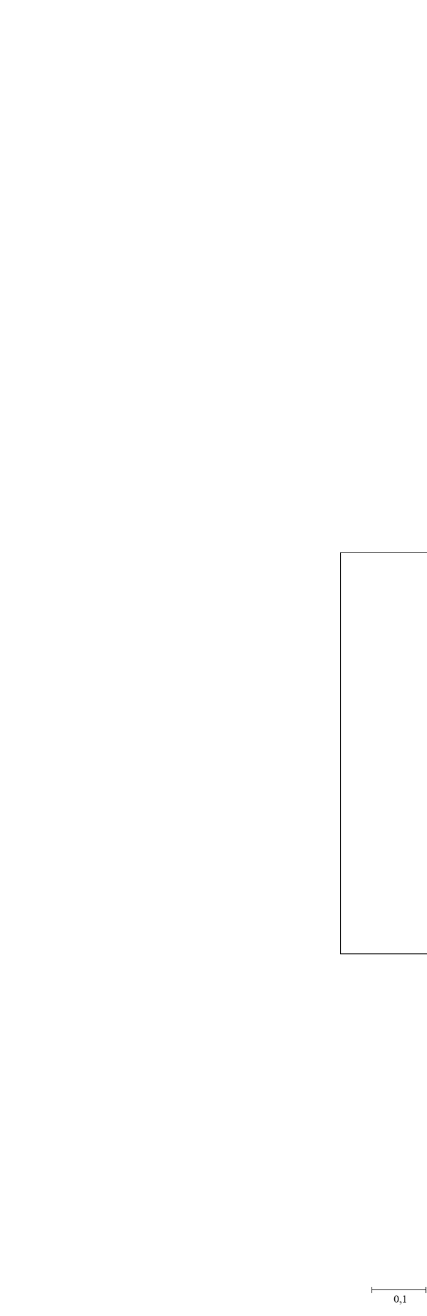
Table 4. Results revealed that isolates Pso_L7, Pso_L16, and Pso_L19 from the aerial part, as well as strains Pso_R11 and